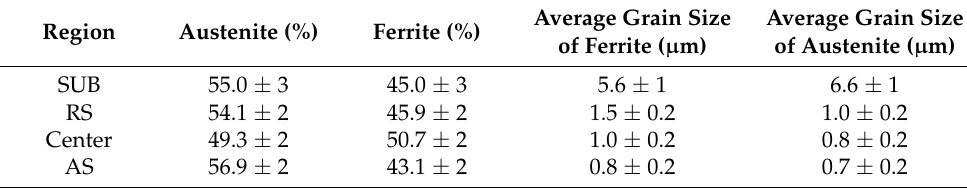
Figure 2. Cross-sectional view of the FSPed SAF 2507 taken with an optical microscope.